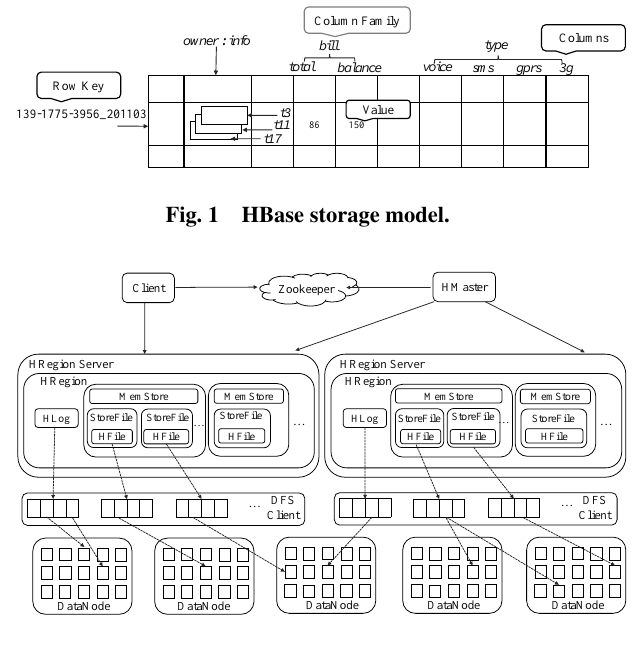
Fig. 2 Architecture of